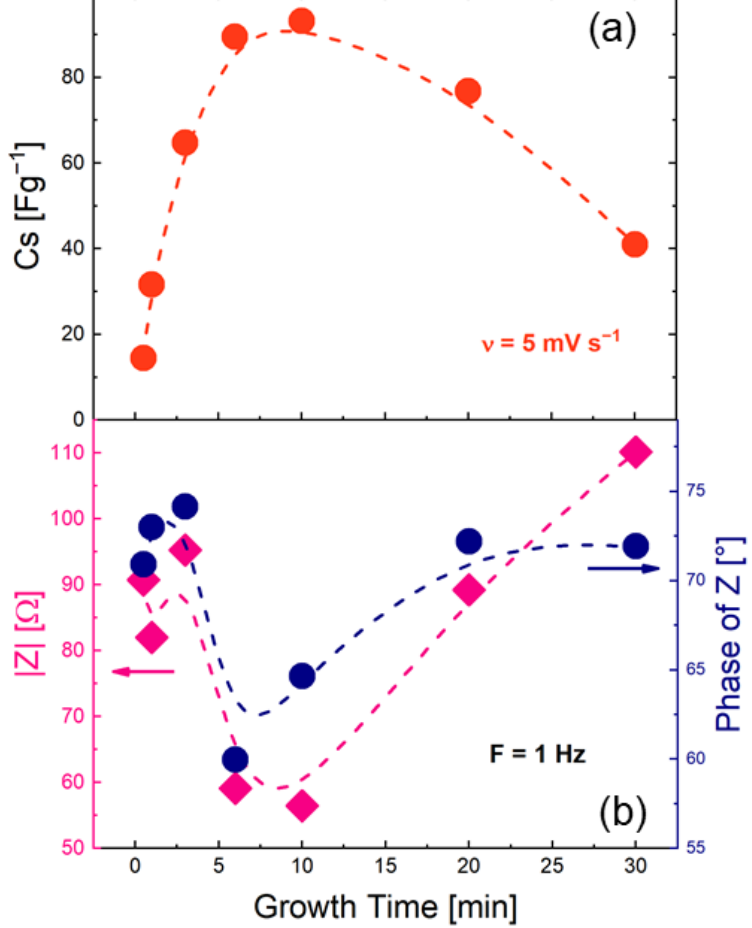
Figure 5. ( a ) C s trend from CV curves acquired at 5 mV s − 1 for all growth times analyzed and ( b ) impedance modulus and phase angle amplitude (magenta and blue symbols, respectively) trends (F = 1 Hz) as a function of growth time.